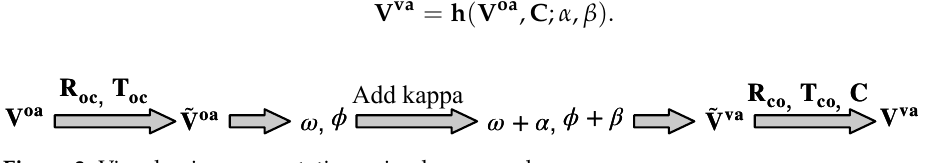
Figure 3. Visual-axis representation using kappa angle.